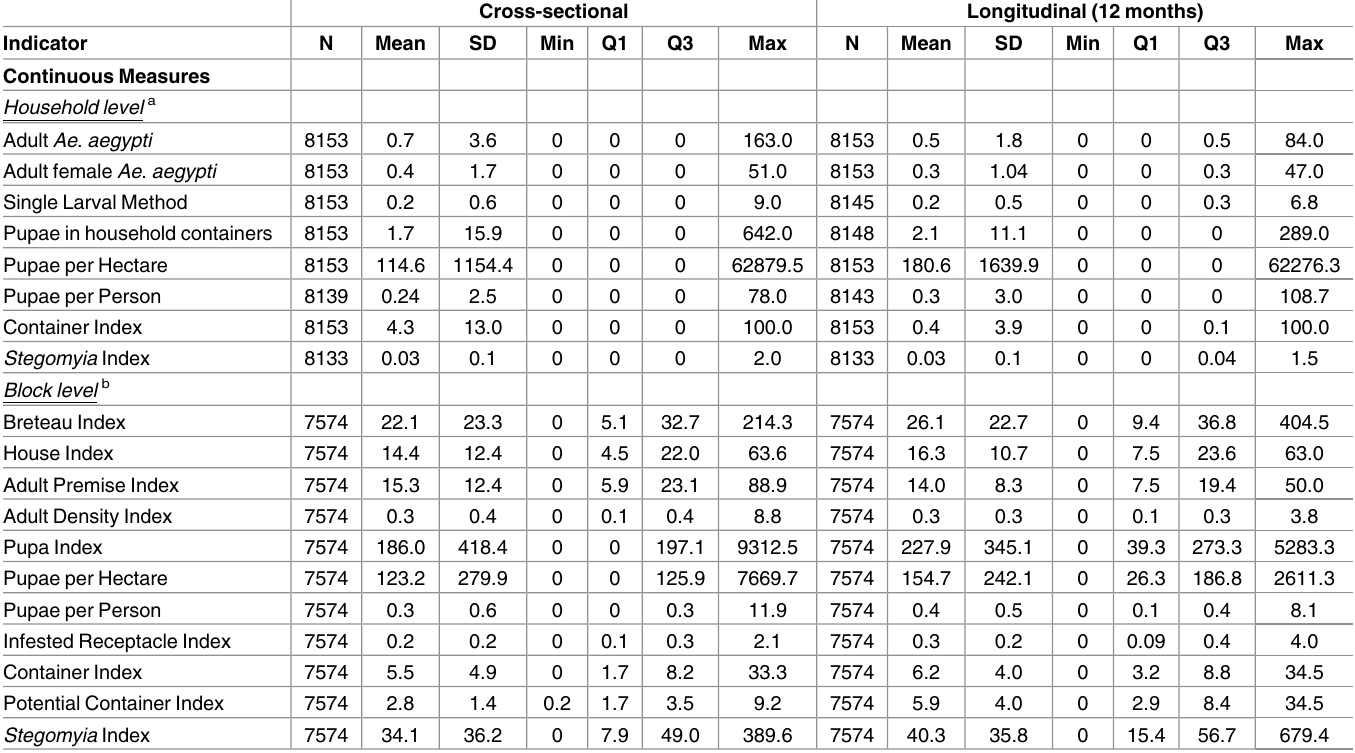
Table 3. Distribution of continuous entomological monitoring indicators for serological observations